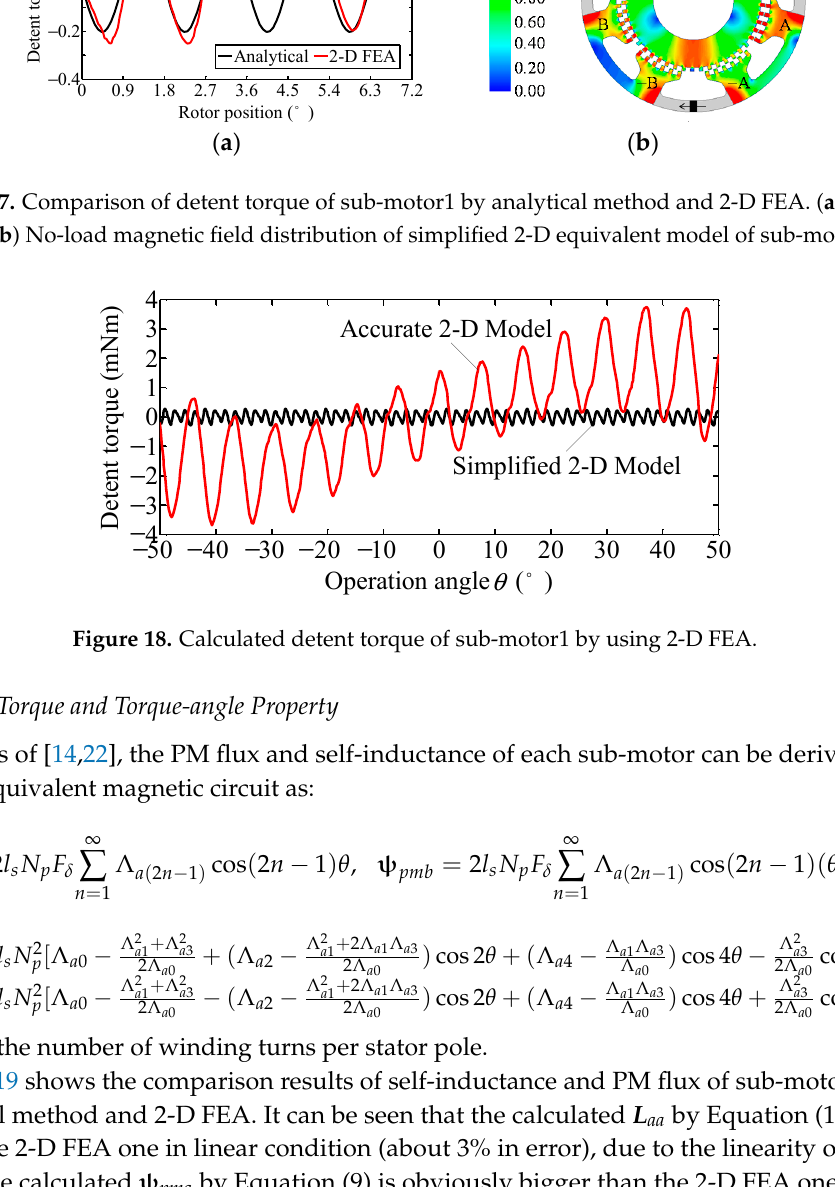
( d ) Figure 16. Harmonic analysis of parallel tooth-layer permeances. ( a ) Sub-motor1, B δ = 0.2 T, Δ θ = π /12 (0.3°); ( b ) Sub-motor1, B δ = 2 T, Δ θ = π /12 (0.3°); ( c ) Sub-motor2, B δ = 0.2 T, Δ θ = π /9 (0.4°); ( d ) Sub-motor2, B δ = 2 T, Δ θ = π /9 (0.4°). 5.2. Detent Torque According to Equation (5), the Λ a_unequal can be alternatively expressed as: _